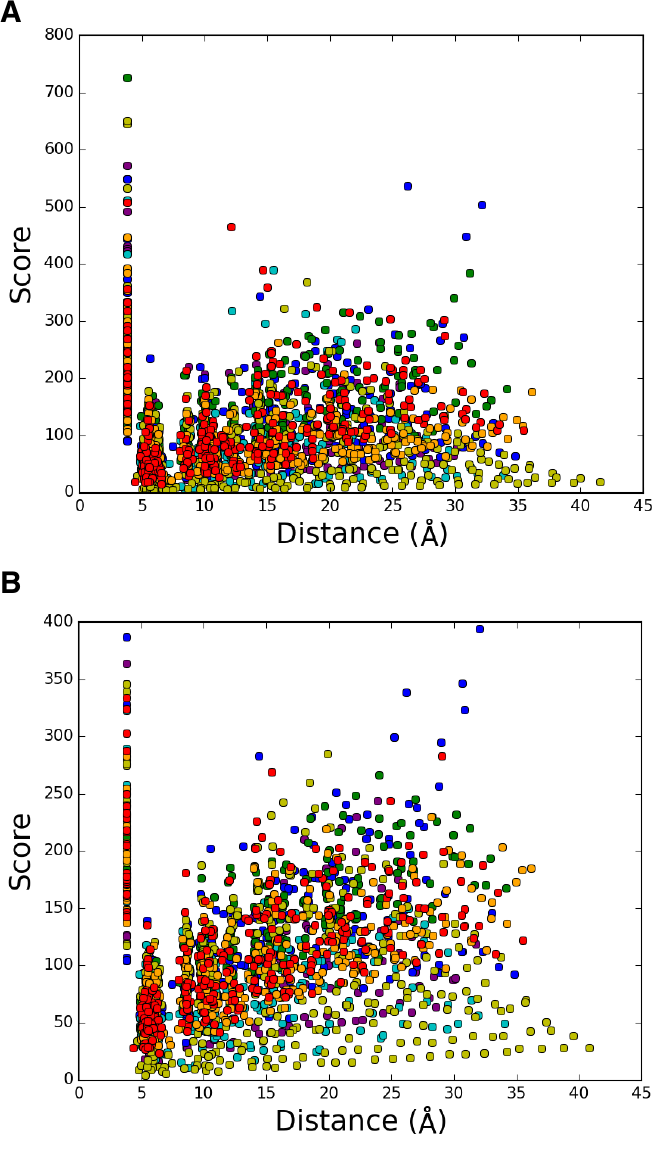
Figure S6. Correlation between score and the average distance for 1,992 intrahelical pairs without a chain obtained from cryo-electron microscopy entry 2AT9 in ( A ) set 1 and ( B ) set 2, The pairs are colored as follows; purple, helix A; blue, helix B; cyan, helix C; green, helix D; yellow, helix E; orange, helix F; red, helix G.